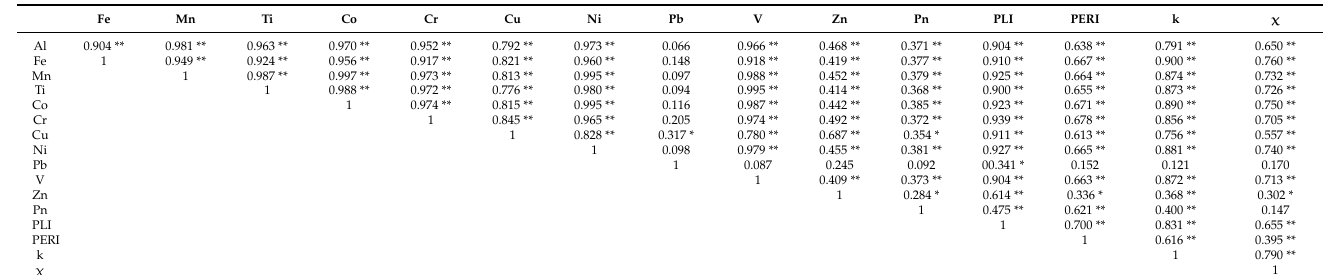
Table 4. Pearson’s correlation coefficient for all variables ( n = 51).